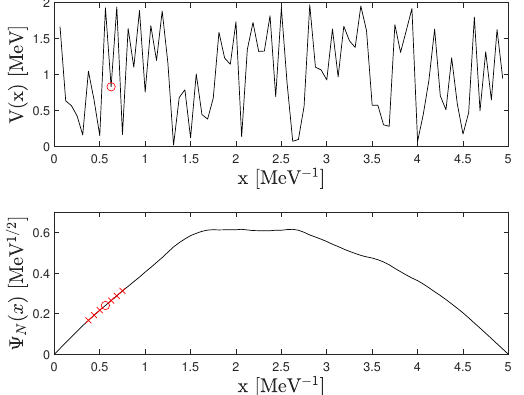
Figure 4. One generated random potential and its corresponding bound sate, which is used to identify the Volterra kernels. From every sample, one randomly generated point (red circle) is chosen for the training data. If the memory of the Volterra system is M = 3, the corresponding neighboring points are also used, which is indicated by red crosses on the bottom